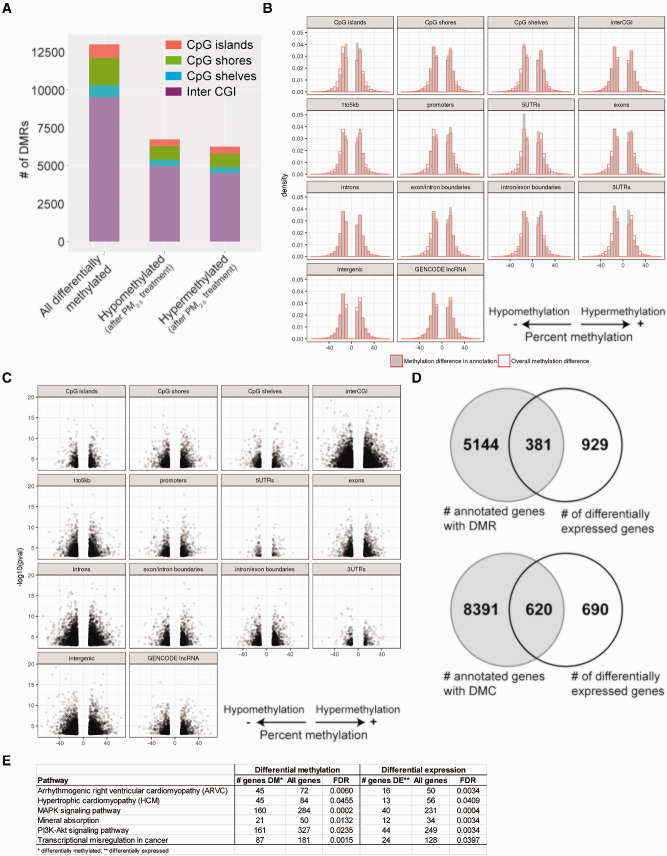
DNA methylation changes after 24-h treatment with 30 µg/cm2 of PM2.5. (A) Graphical representation of the number of differentially methylated regions (DMRs, defined by >10% difference in methylation and adjusted P-value < 0.05), broken down by location (CpG islands vs. shores vs. shelves) and relative methylation change (hyper- vs. hypo-) after PM2.5 treatment. (B) Density of differentially methylated regions mapped by gene annotation relative to overall difference in methylation observed. (C) Volcano plot of differentially methylated regions with degree and direction of DNA methylation change plotted against adjusted P-value. (D) Venn diagram of genes with differentially methylated regions (DMRs) or at least one differentially methylated CpG locus (DMCs) compared to genes that were differentially expressed. (E) Pathway analysis of genes that were both differentially expressed and differentially methylated after single-dose PM2.5 exposure identified specific statistically enriched pathways common to both groups.